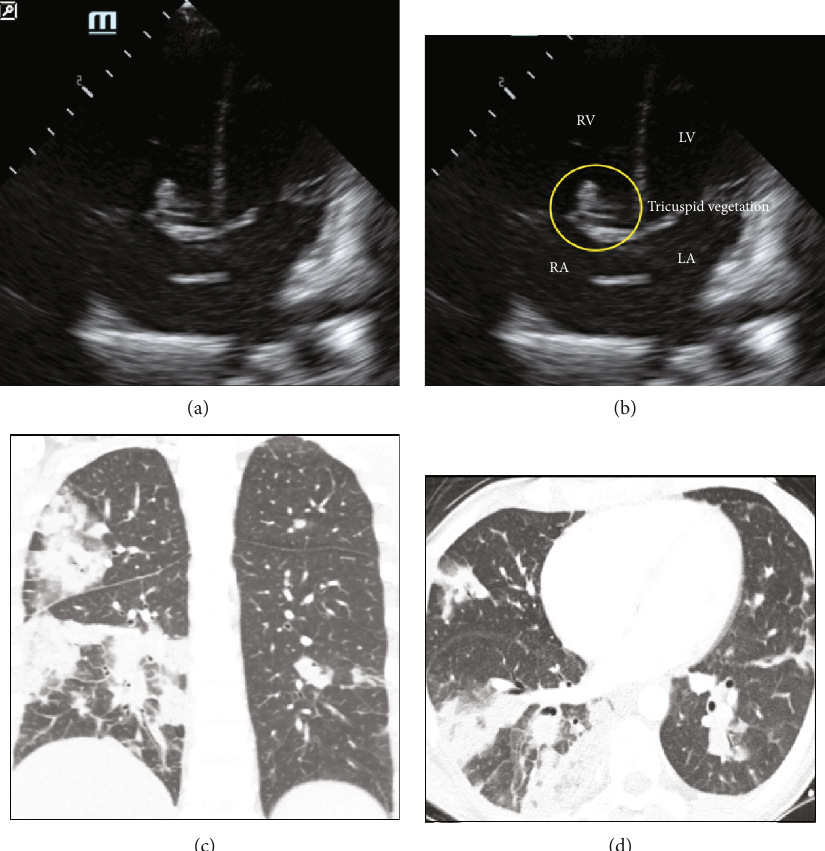
Figure 2: (a, b) Representative images from the bedside echocardiogram (apical four-chamber view) demonstrating tricuspid vegetations (circle). (c, d) Representative images from the CT angiogram (coronal and axial images, respectively) revealing the right-lower-lobe wedge